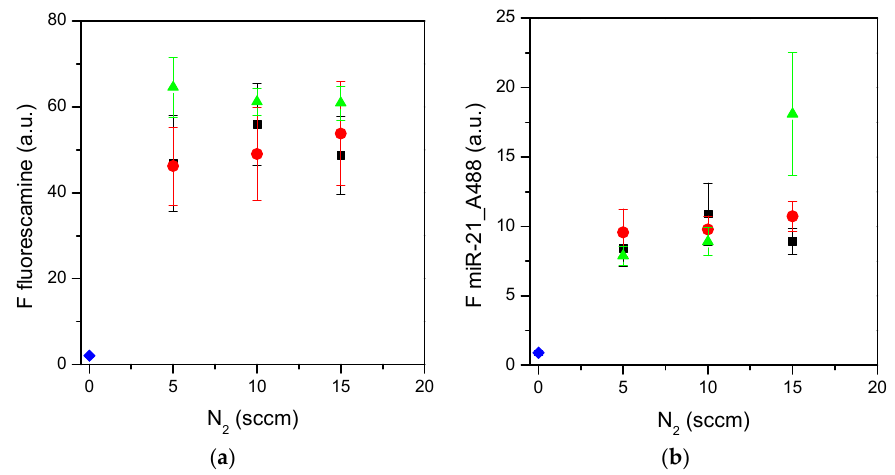
Figure 6. Fluorescamine assay ( a ) and miR-21 adsorption ( b ) on surfaces plasma-coated using CH 4 /NH 3 /H 2 mixtures. Fluorescence data are reported as a function of the N 2 flow rate. Black squares refer to 10 sccm NH 3 , red circles to 15 sccm, and green triangles to surfaces prepared with 20 sccm of NH 3 . Blue diamonds near zero represent control fluorescence measured on pure silicon surfaces. Data are means of at least three surfaces; standard errors are reported ( n ≥